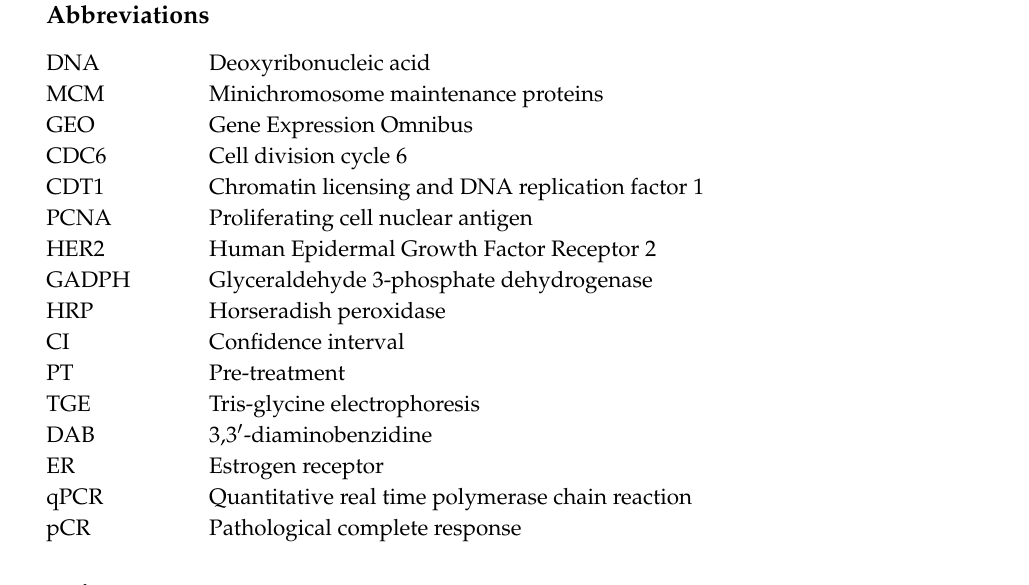
Figure S1: Breast cancer combined datasets with different histological grades, Figure S2: Breast cancer patient different subtypes, Figure S3: Relative expression of MCM10 in stable Overexpression (OE) in MCF 7 cell lines. Table S1: Clinicopathological parameters of patient samples used for qPCR analysis of